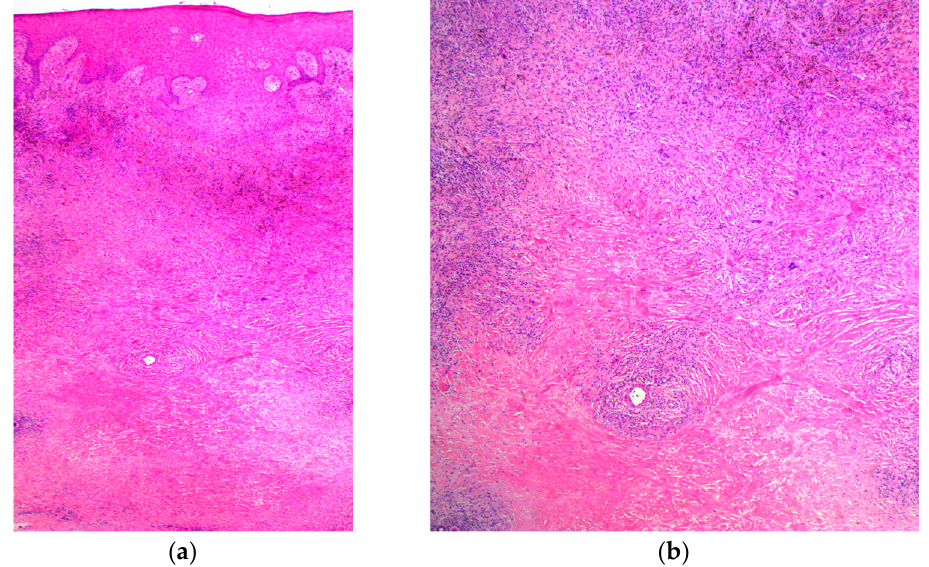
Figure 7. Histological features of necrotising granulomatous reaction. Note the necrosis in the der- mis, surrounding giant cells and some pigment. ( a ) low power ; ( b ) high